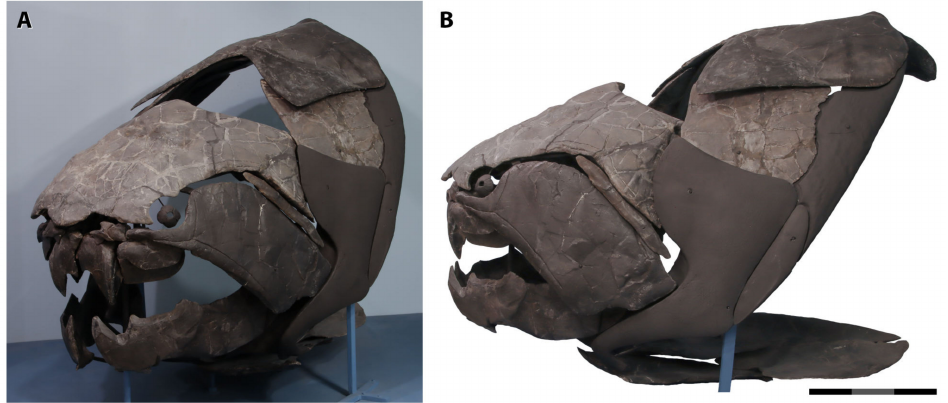
Figure 5. CMNH 5768, the largest complete individual of Dunkleosteus terrelli in oblique left lateral ( A ) and left lateral ( B ) view. Some of the thoracic plates are reconstructed but the skull and ventral armor are entirely real. The proportions of the reconstructed plates closely resemble other specimens of Dunkleosteus . Note ( B ) is taken at a slightly oblique angle because a camera could not be placed in perfectly lateral view. Scale = 30 cm, but only applies to ( B ), ( A ) is